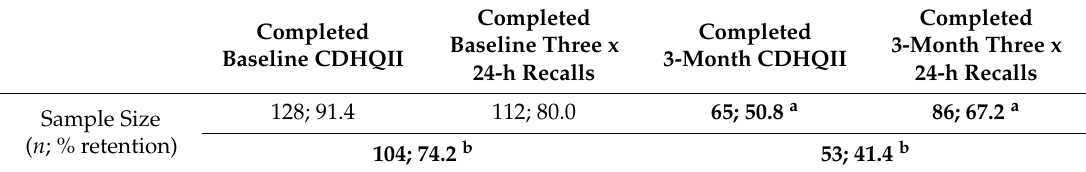
Table 3. Proportion of participants completing dietary assessment